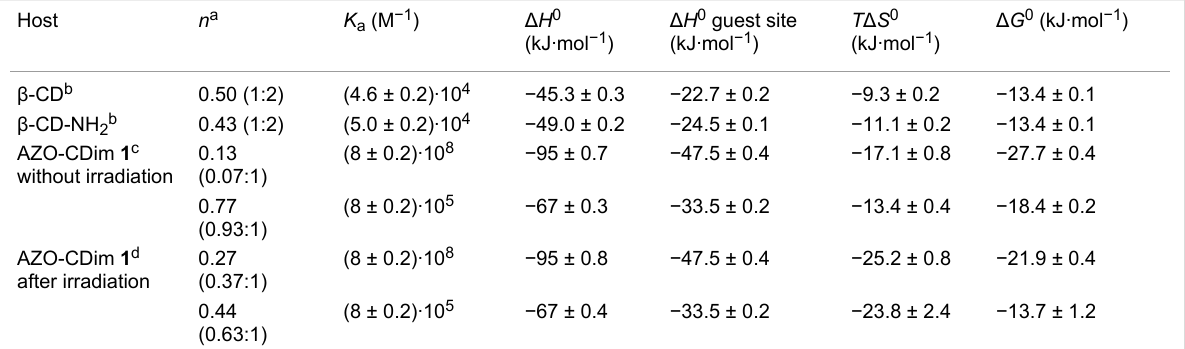
Table 1: Thermodynamic parameters deduced from ITC experiments for the different host–guest systems studied (temperature 298 K in water).